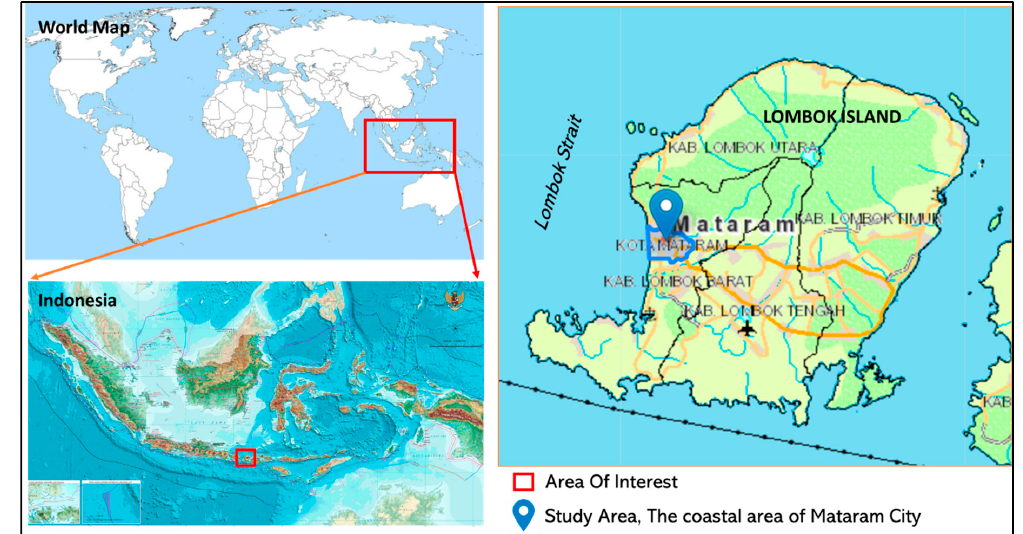
Figure 1. A map of the study site (source: [22,23]).